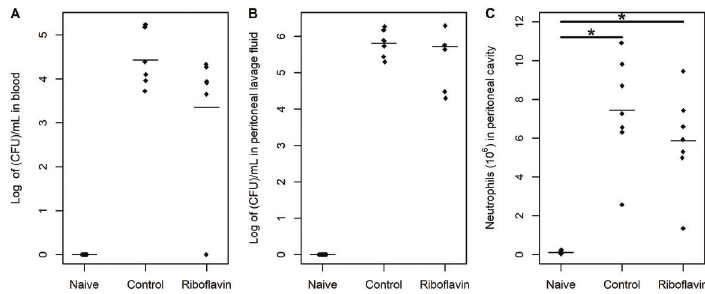
Figure 2. Quanti fi cation of bacteria reported as log of colony-forming units (CFU)/mL in blood ( A ) and peritoneal lavage fl uid ( B ) of naïve, control, and study groups (n=5 to 7 animals per group). C , Quanti fi cation of neutrophils reported as number of neutrophils (cid:1) 10 6 in peritoneal cavity of naïve, control, and study groups (n=7 animals per group). The horizontal bars represent means. *Signi fi cant difference between groups (linear regression models adjusted under the Bayesian